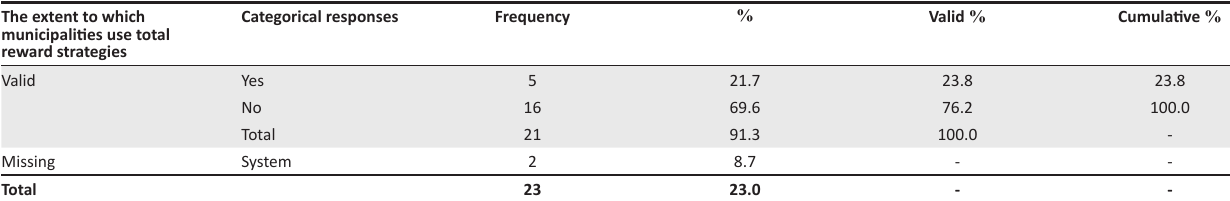
TABLE 1: Extent to which municipalities have adopted total reward